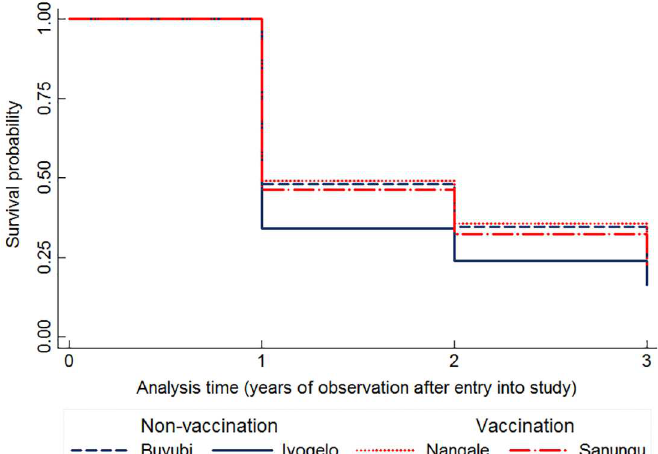
Fig 3. Kaplan-Meier survival estimatesindicating the probability of a dog surviving until the next year of observation after it was first encountered. Dogs in Iyogelo village(non-vaccination, indicatedby solid blue line) had lower survival probabilities compared to dogs in Buyubi (non-vaccination,blue dashed line), Nangaleand Sanungu(vaccination, red dotted line and dash-dot respectively) throughoutthe study period. The x-axis (analysistime) indicatesthe year of observation after a dog was enrolledinto the study and the y- axis indicatesthe survival